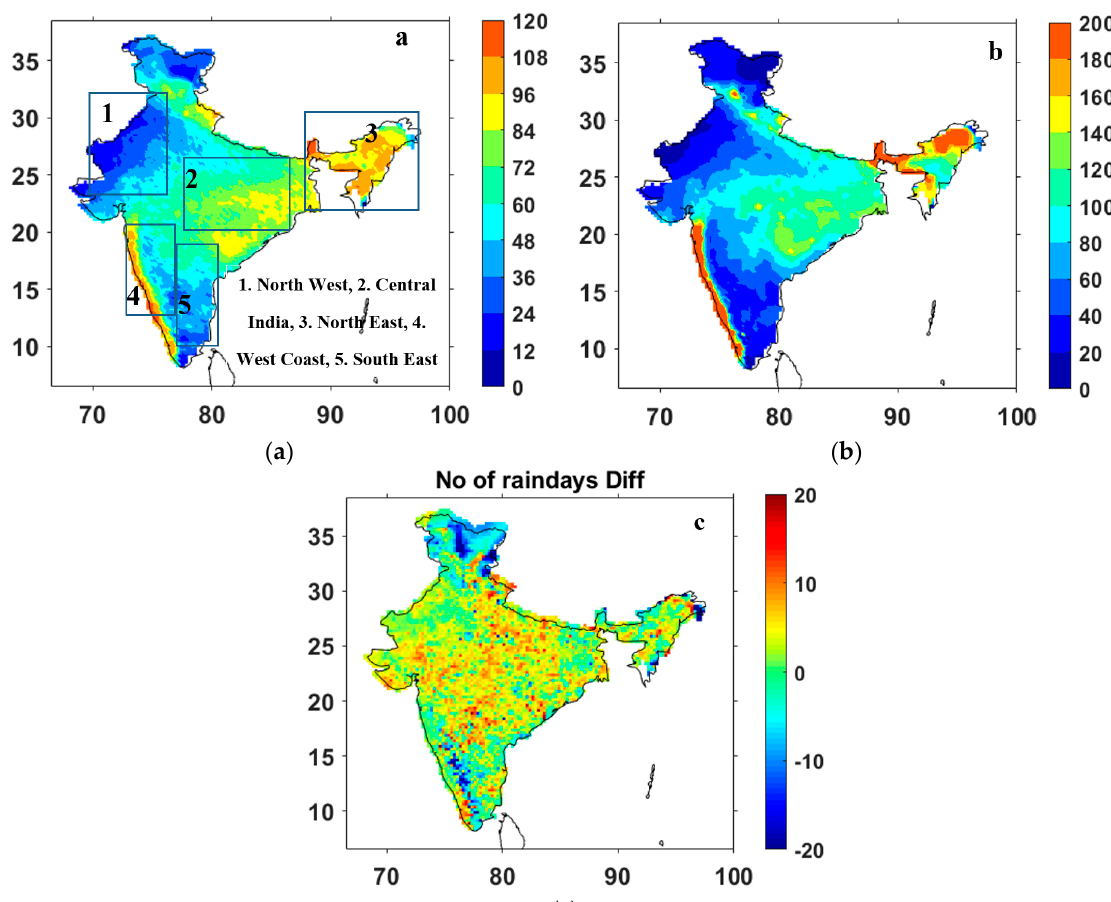
Figure 1. India Meteorological Department (IMD) gridded summer rainfall from 1951-2018 (a) Climatology of the number of rainy days (where rainfall>0.5mm/day on each grid), (b) Rainfall climatology (cm), (c) Difference between the number of rainy days from E-Period and L-Period. Black boxes numbered from 1 to 5 represent five homogenous regions of India [1 North West (NW), 2 Central India (CI), 3 North East (NE), 4 West Coast (WC), 5 South East (SE)].